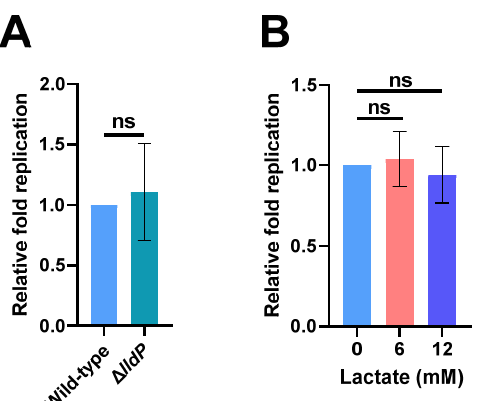
Figure 3. Increased lactate production in macrophages has no effect on Salmonella enterica serovar Typhi ( S. Typhi) intracellular replication. ( A ) Replication of wild-type S . Typhi and Δ lldP mutant strain that cannot utilize lactate in THP-1 cells. ( B ) Replication of S . Typhi in 0, 6, or 12 mM lactate- treated THP-1 cells. ( A , B ) Data were obtained from three independent experiments and analyzed using Student’s t -test. ns, not significant.